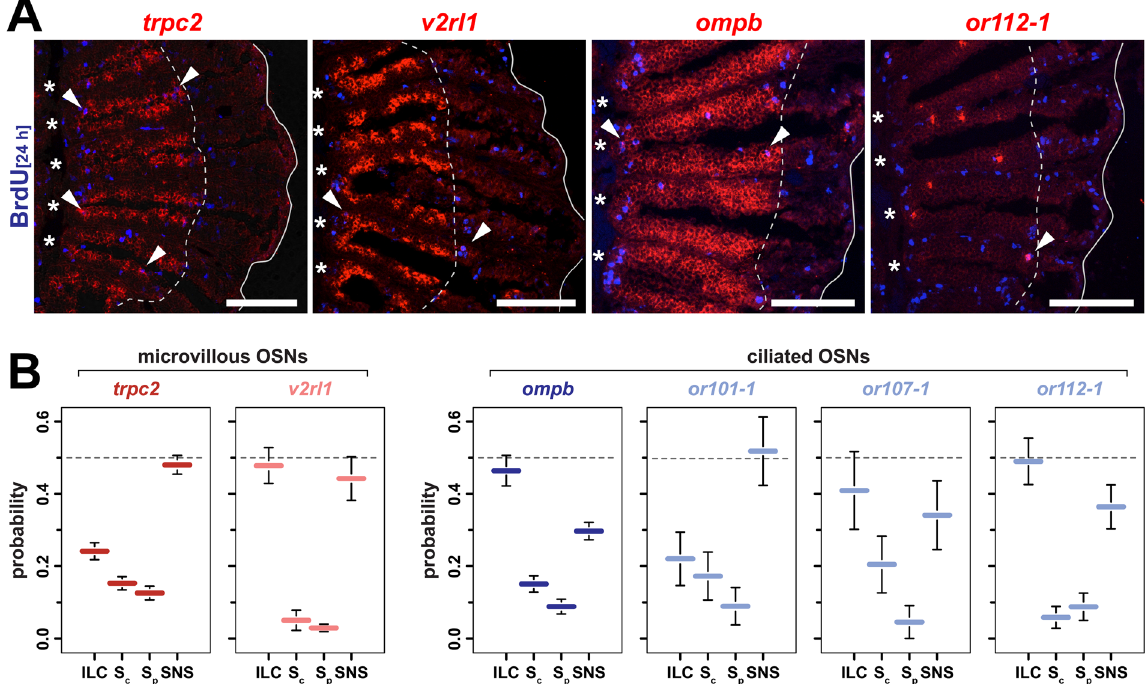
Figure 5. Functional equivalence and bias in OSN neurogenesis at the ILC and SNS. ( A ) In situ -hybridization (red) for markers of distinct OSN subtypes and immunohistochemistry against BrdU (blue) at 8d ( trpc2 , ompb ) and 4d ( v2rl1 , or112 - 1 ) following 24 h BrdU incubation. The trpc2 gene is expressed by all microvillous OSNs, a larger subset of which also expresses the vomeronasal receptor v2rl1 . Ciliated OSNs label positive for ompb and express specific olfactory receptor genes, such as or112 - 1 . For each gene, double-positive cells (arrowheads) can be found at the interlamellar curves (asterisks) and the sensory/nonsensory border (dotted line). The solid line demarcates the outline of the section of which only one half is shown. Scale bars: 100 µ m. ( B ) Quantification of OSN subtype neurogenesis at different proliferation sites. The sensory OE was subdivided into four equal segments (ILC: interlamellar curves, Sc: sensory central, Sp: sensory peripheral, SNS: sensory/nonsensory border) and the occurrence of marker/BrdU double-positive OSNs was scored for each segment for the general microvillous marker trpc2 (red), the vomeronasal-like receptor v2rl1 (light red), the ciliated OSN marker ompb (blue) and the three classical OR genes or101 - 1 , or107 - 1 , and or112 - 1 (light blue) expressed by ciliated OSNs. A subtype-specific bias exists for neurogenesis at the ILC and SNS. Data represent the mean ± SEM; trpc2 : 607 cells from 5 OE; v2rl1 : 203 cells from 4 OE; ompb : 563 cells from 2 OE; or101 - 1 : 35 cells from 6 OE; or107 : 25 cells from 7 OE; and or112 - 1 : 76 cells from 8